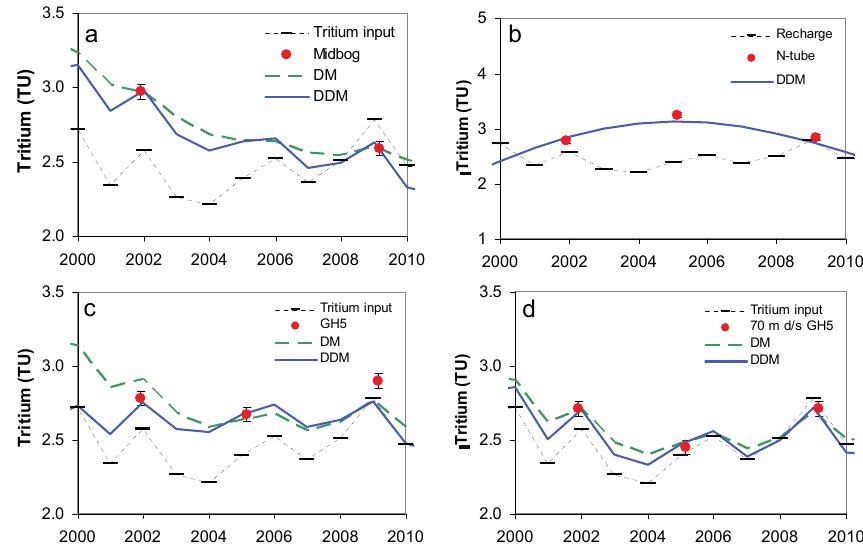
Fig. 6. Tritium measurements and simulations for midbog, N-tube, GH5 and 70md/sGH5